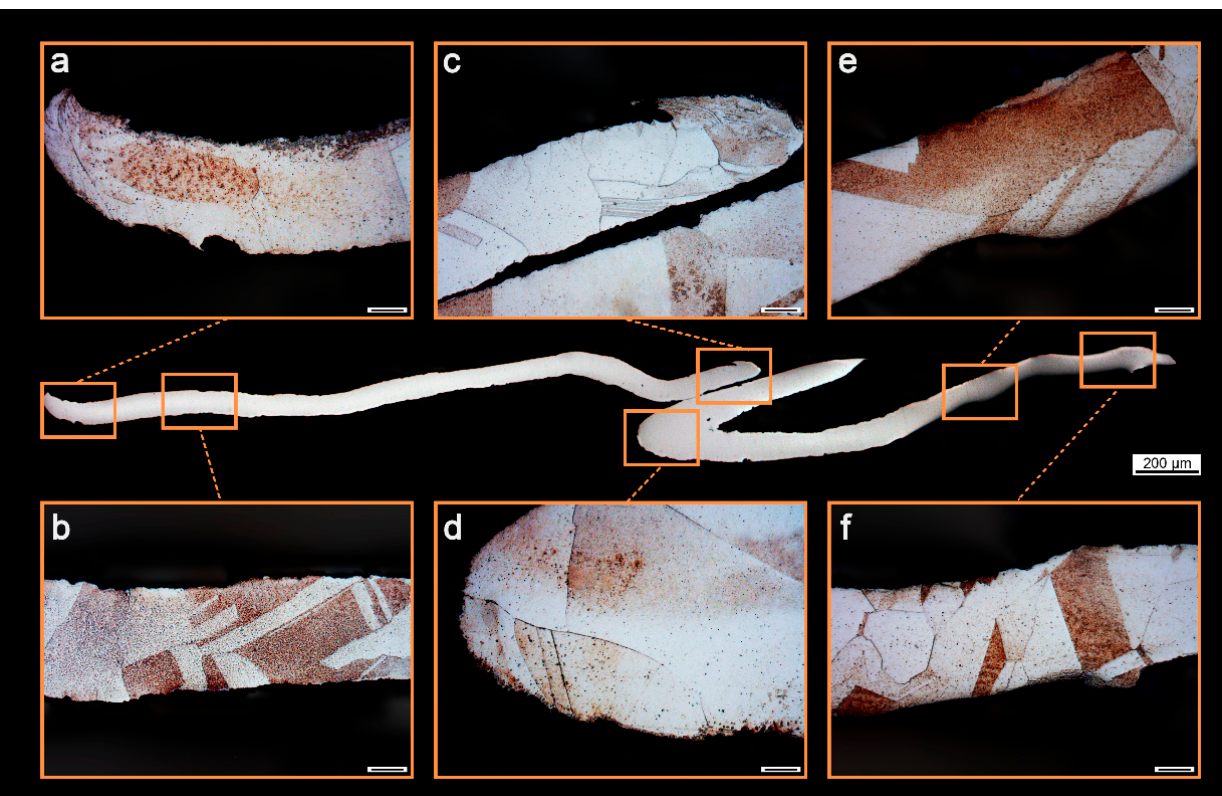
Figure 4. The full range of metallographic information obtained through aqua regia etching + con- Figure 4. Thefullrangeofmetallographicinformationobtainedthroughaquaregiaetching + concentrated centrated ammonia/sodium thiosulfate solution removal of impurities (scale bar, 200 μ m). ( a ) Etch- ammonia/sodium thiosulfate solution removal of impurities (scale bar, 200 µ m). ( a ) Etchant: aqua regia with dilution ratio 1:1.5; etching duration: 40 s; impurity removal: 1 mol/L sodium thiosulfate